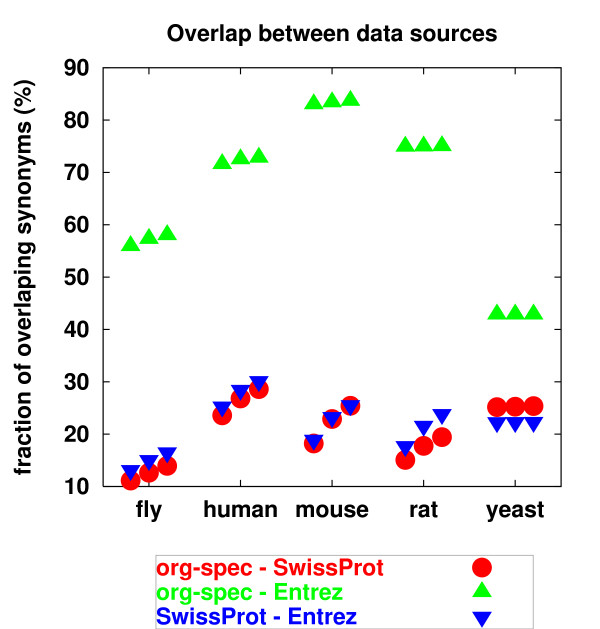
Overlap between different data sources. The overlap between gene name dictionaries compiled from different data sources varies for different organisms and pairs of databases. Organism-specific databases and Entrez Gene show highest overlap for all organisms. For notation see Figure 1, for details see section 'Overlap between different data sources'.